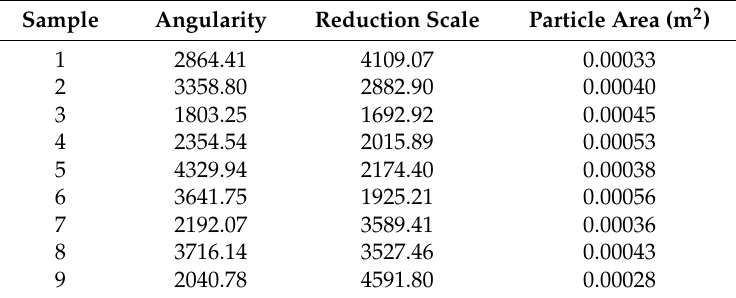
Table 1. Summaries of the two-dimensional images.